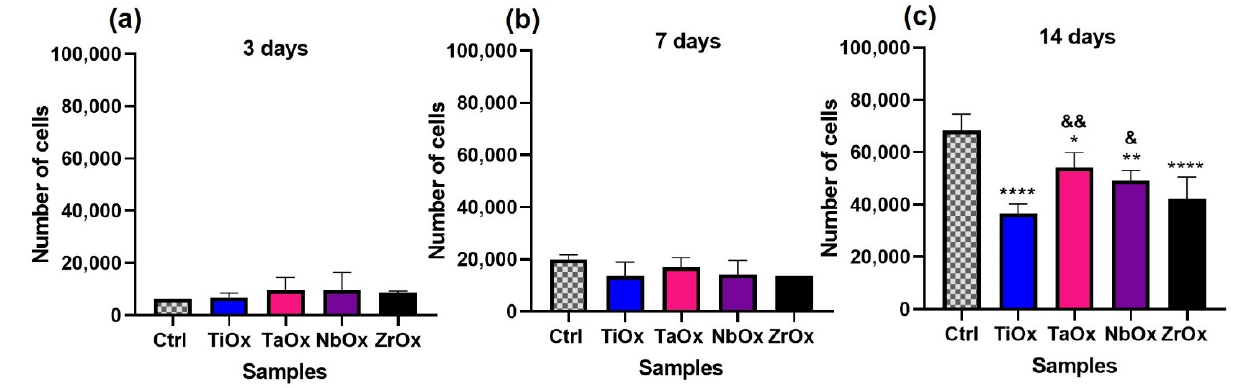
Figure 7. Quantitative evaluation of BM-MSC viability cultured on the coatings at ( a ) 3 days, ( b ) 7 days, ( c ) 14 days of culture. Thermo Fisher Alamar Blue TM cell viability reagent kit was used. Ctrl corresponds to BM-MSC cultured on the surface of standard tissue culture plates. Data are presented as the mean ± standard error using three independent cultures per variable and analyzed by one-way ANOVA using a Dunnett’s post hoc test. * p ≤ 0.05 vs. Ctrl; ** p ≤ 0.001 vs. Ctrl; **** p ≤ 0.0001; & p ≤ 0.05 vs. TiOx; && p ≤ 0.01 vs. TiOx.